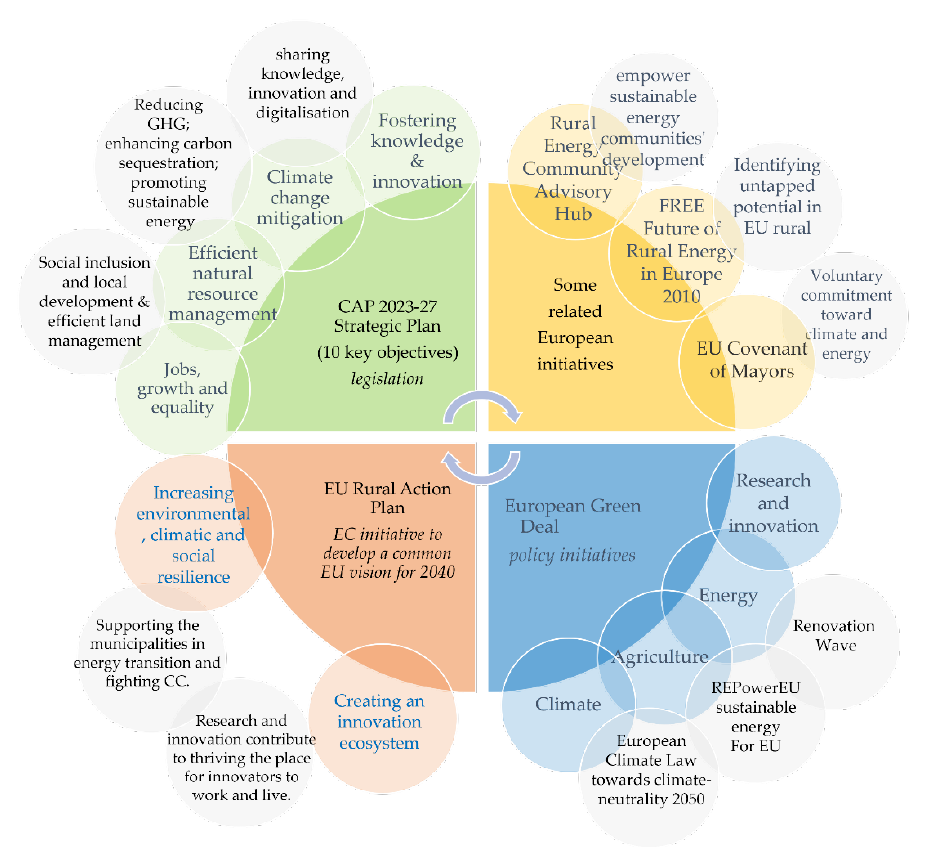
Figure 3. Mapping the core of the energy communities concept in current European policies and initiatives.